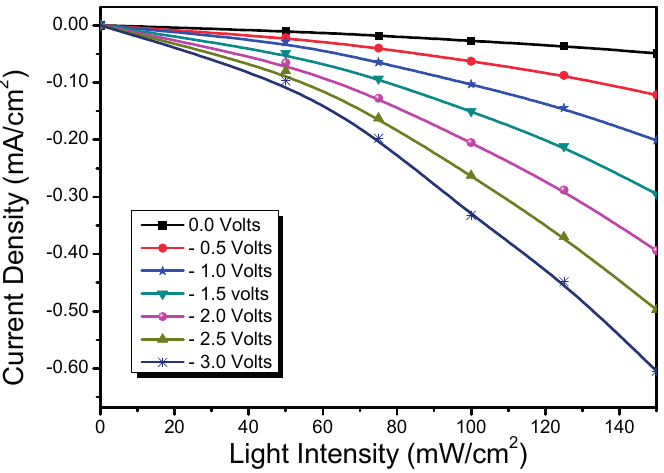
Figure 6. Light intensity v’s. current density measurements for ITO/PEDOT:PSS/PFO- DBT:MEH-PPV:PC 71 BM/LiF/Al photodetector at different bias voltages (0 to − 3 V) at room